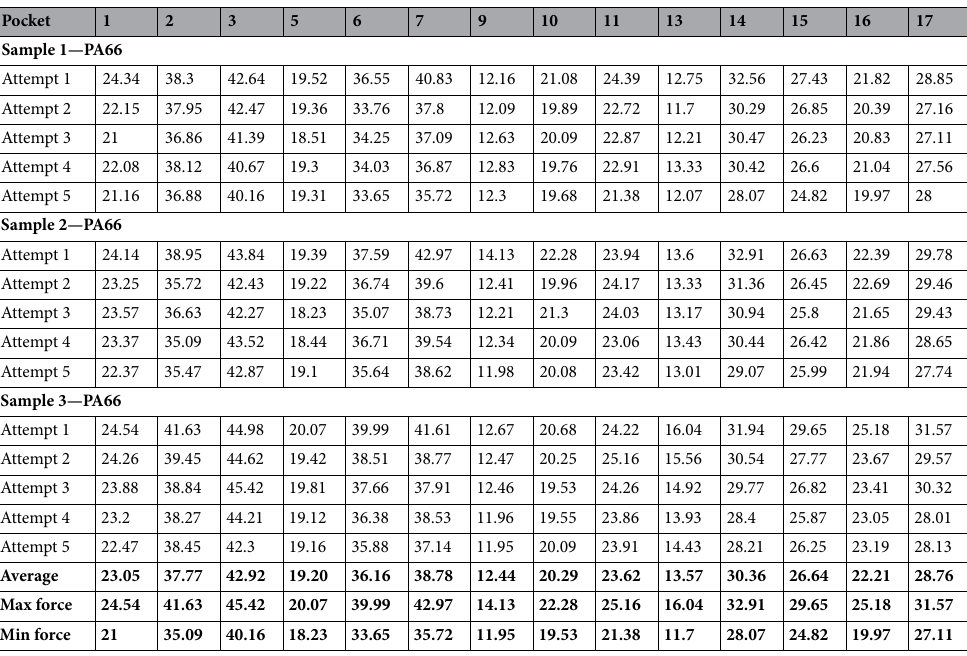
Table 4. Measured forces of PA66 cages. The [Bold] values are used in the subsequent calculations and